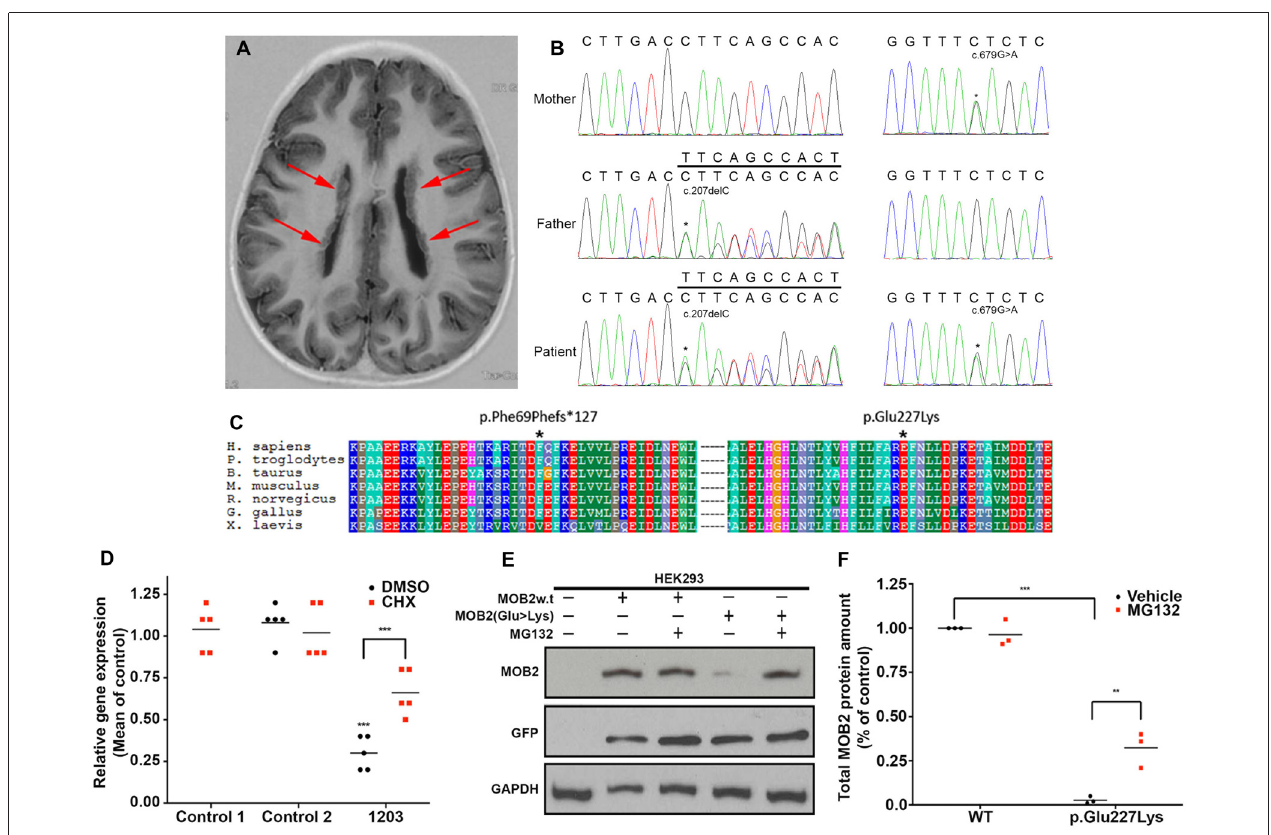
FIGURE 1 | Biallelic variants in MOB2 affect mRNA and protein stability in vitro . (A) Brain MRI scan of patient 1203, showing the presence of bilateral periventricular nodular heterotopia (PH; red arrows). (B) Sequence traces illustrating the MOB2 sequence variants c.679G > A, present in mother and patient, and c.207delC, present in father and patient. (C) Multiple sequence alignment (ClustalX) of the human MOB2 protein against various species. Columns are colored by conservation and property. ∗ Denotes the positions of the mutated residues—Phe69 and Glu227—substituted by each of the alleles discovered in individual 1203. (D) Mean expression of MOB2 in age-matched controls and individual 1203 ( n = 5) fibroblasts when treated with vehicle/DMSO (black circles) and cycloheximide (CHX; red squares), as determined by real-time PCR. Expression was normalized against GAPDH and DIMT1 housekeeping genes in the same sample using the relative standard curve method. Values were then subsequently normalized to control 1 DMSO treatment using the delta-delta Ct method. (E) HEK293 cells were transiently transfected with a bi-cistronic vector expressing both the green fluorescent protein (GFP) and wild-type (w.t) or mutant (Glu227Lys) MOB2 . At 24 h after transfection, cells were treated with DMSO, or the proteasome inhibitor, MG132, for 24 h, after which total cell lysates were prepared and subjected to western blot analysis using anti-MOB2, anti-GFP and anti-GAPDH as a loading control. (F) Quantifications representing three biological replicates of (E) summarizing total MOB2 protein amount with or without MG132 treatment. Lysosomal degradation pathways may account for the remaining degraded MOB2. ∗∗ P < 0.01; ∗∗∗ P < 0.001, Mann-Whitney U